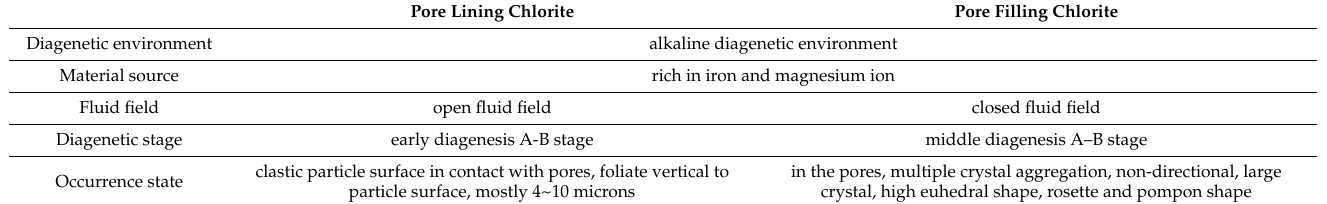
Table 2. Similarities and differences of occurrence and formation mechanism of chlorite.